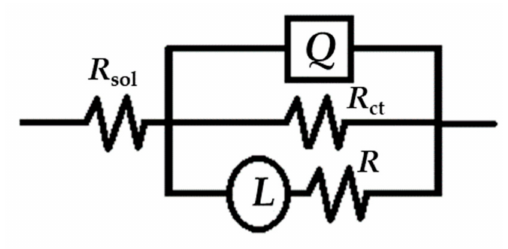
Figure 9. Equivalent circuit of Al–5Zn–0.03In– x Er